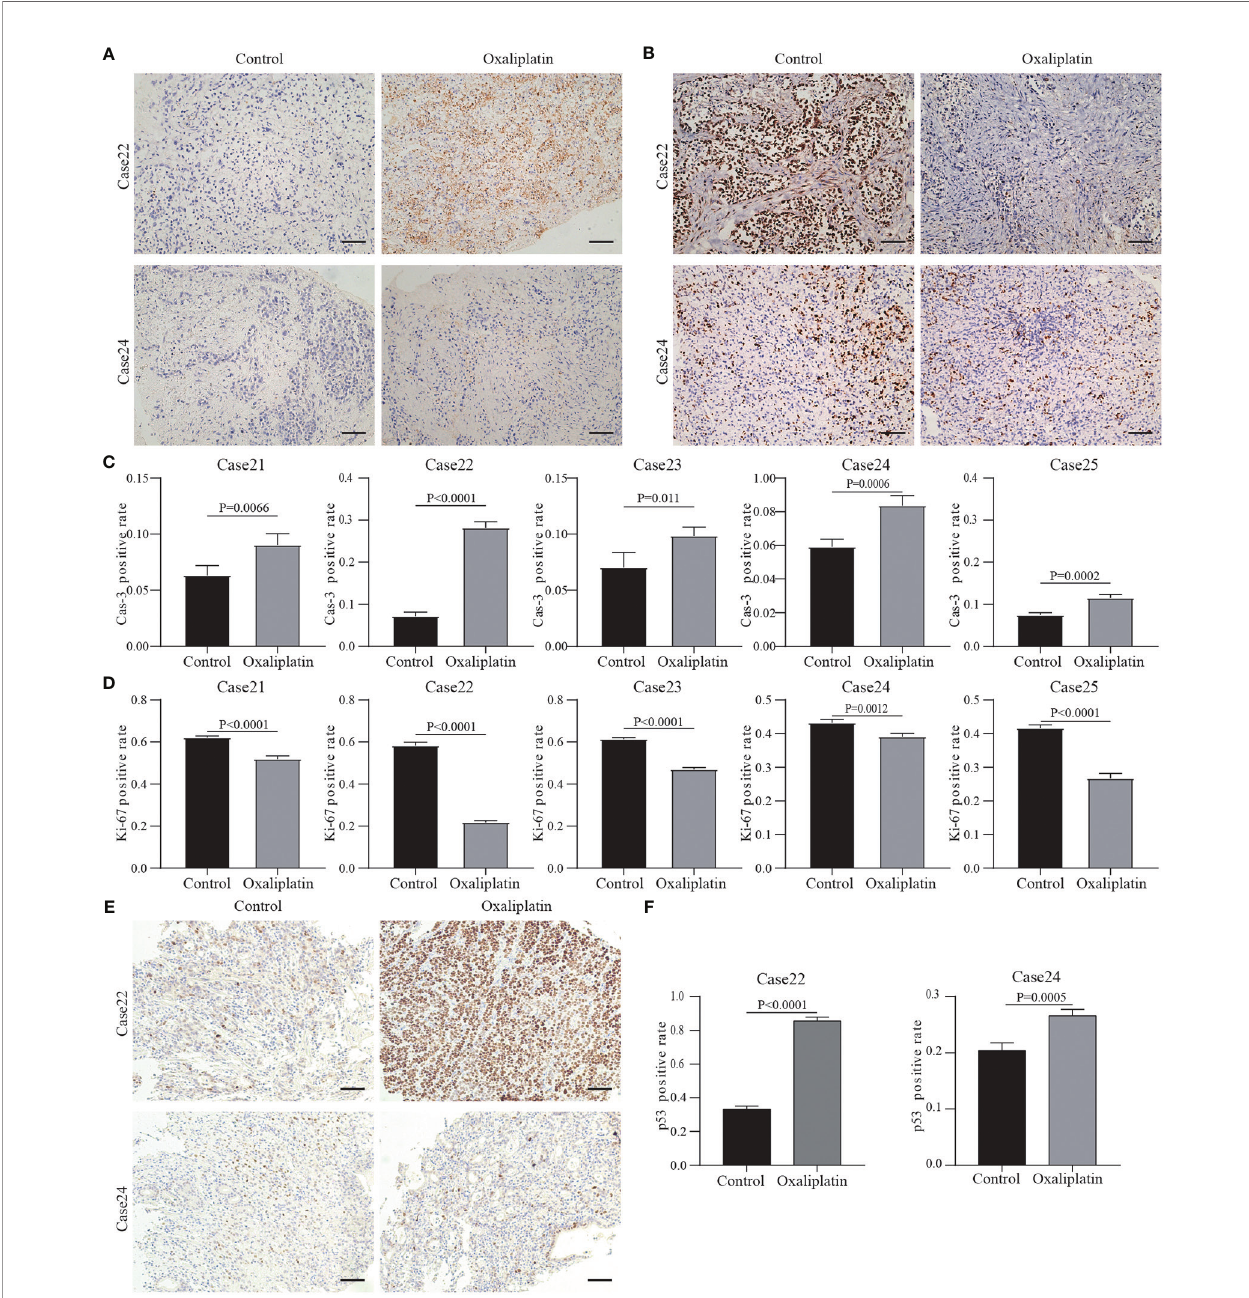
FIGURE 6 | Results of drug response tests to oxaliplatin based on 3D GC tissue culture. (A) The tumor tissues of Case22 and Case24 were stained with Cas3 after 3 days of culture and oxaliplatin treatment. (B) The tumor tissues of Case22 and Case24 were stained with Ki67 after 3 days of culture and oxaliplatin treatment. All images are the same magni fi cation, scale bar, 100 m m. (C, D) Quantitative analysis of Ki67 and Cas3 in tissues of Case21-25. (E) The tumor tissues of Case22 and Case24 were stained with p53 after 3 days of culture and oxaliplatin treatment. All images are the same magni fi cation, scale bar, 100 m m. (F) Quantitative analysis of p53 in tissues of Case22 and